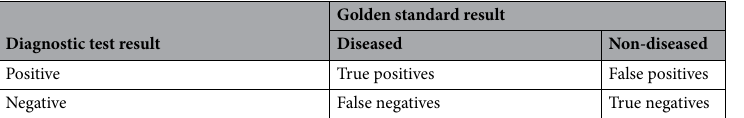
Table 2. 2x2 contingency table. Diagnostic test result in relation to the golden standard result. Subjects with diagnostic test values less than the threshold are classified as positive and subjects with diagnostic test values greater than or equal to the threshold are classified as